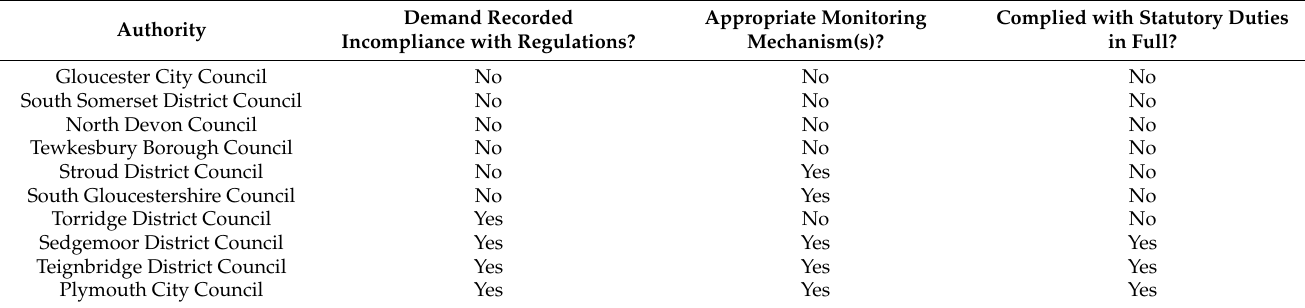
Table 16. Compliance with statutory duties set out in the 2015 Act (as amended).